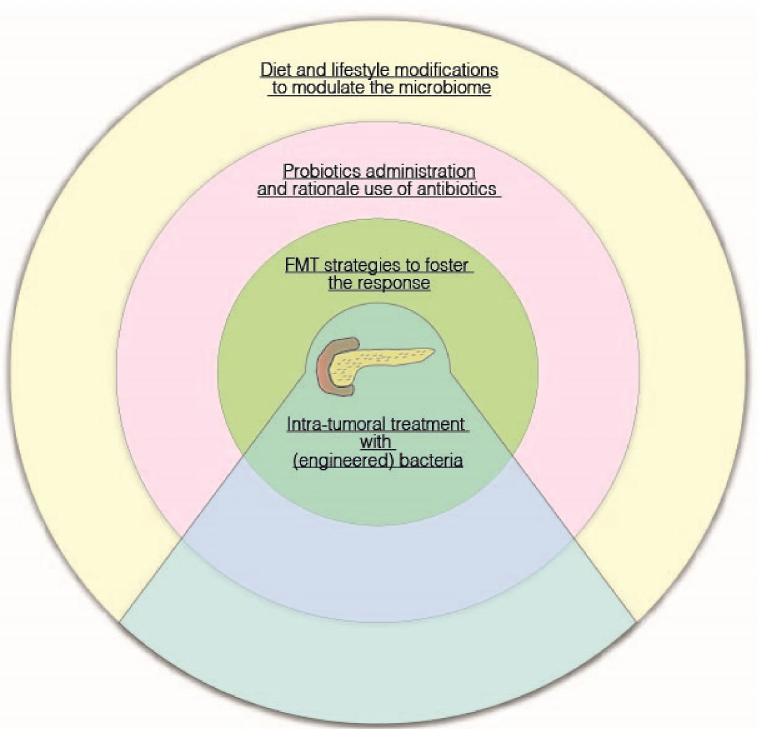
Figure 2. A figurative “dartboard” on potential microbiota-related therapeutic strategies in pancreatic